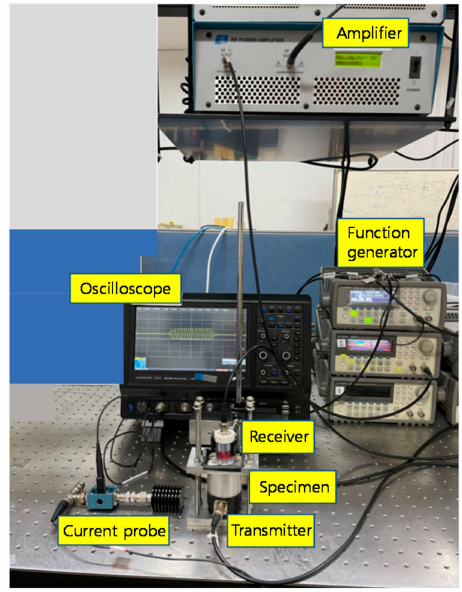
Figure 5. Experimental setup for harmonic generation measurement in the through-transmission mode using a contact transmitter and an air-coupled